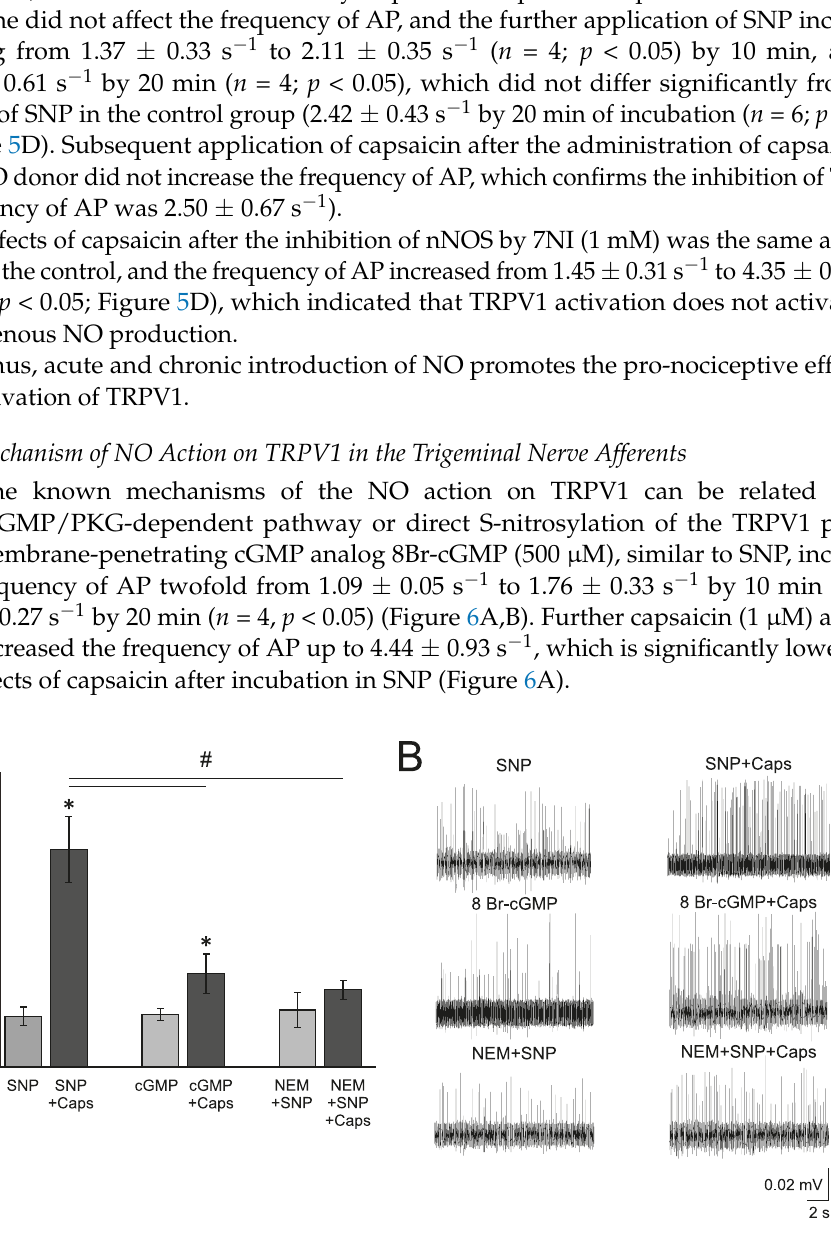
Figure 6. Mechanism of the modulating effect of NO on TRPV1 receptors. ( A ) Histogram showing the maximum frequency of AP per 5 min in the trigeminal nerve after the application of the NO donor SNP (200 µ M) and capsaicin (1 µ M) in the presence of SNP; cGMP analogue—8-Br-cGMP (500 µ M) and capsaicin in the presence of 8-Br-cGMP; N-Ethylmaleimide, (NEM, 25 µ M) together with SNP and capsaicin in the presence of NEM + SNP. ( B ) Sample traces of AP in the trigeminal nerve after the application of SNP and SNP + Caps; 8-Br-cGMP and 8-Br-cGMP + Caps; NEM and NEM + SNP + Caps. Mean ± SEM. * p < 0.05 (compared to SNP or cGMP respectively); # p < 0.05 (compared to the effect of capsaicin +